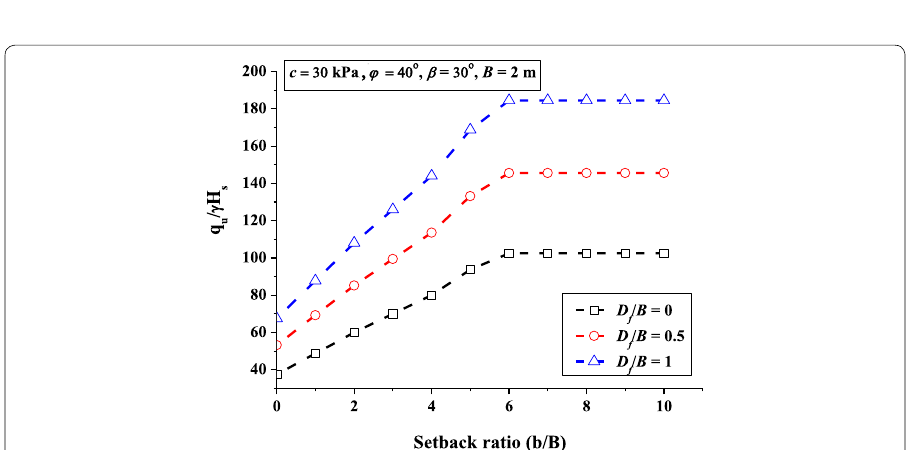
Fig. 13 Typical variation of q u / γH s with embedment depth ratio ( D f /B ) and setback ratio ( b/B